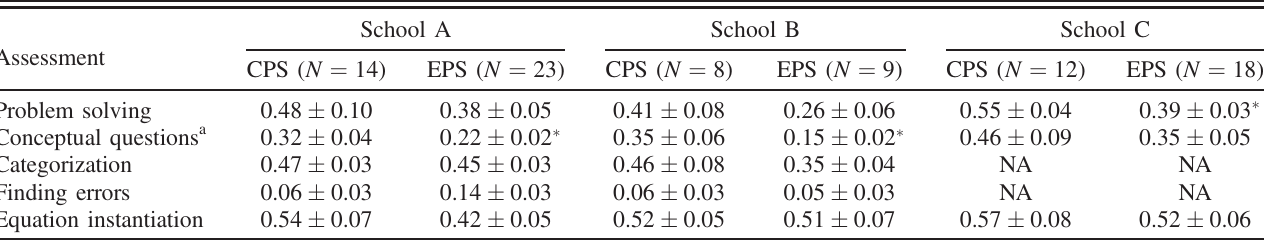
TABLE II. Performance on each assessment by condition and school. The Conceptual Problem Solving treatment group typically scored higher than the Equation Problem Solving control group. Values represent a percent score (cid:2) the standard error of the mean and stars indicate significant differences p < 0 . 05